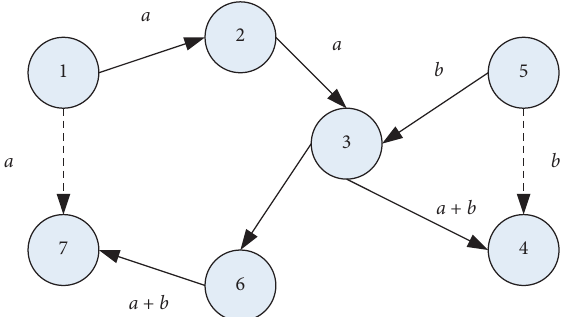
Figure 4: The process of the Verify algorithm to generate code.